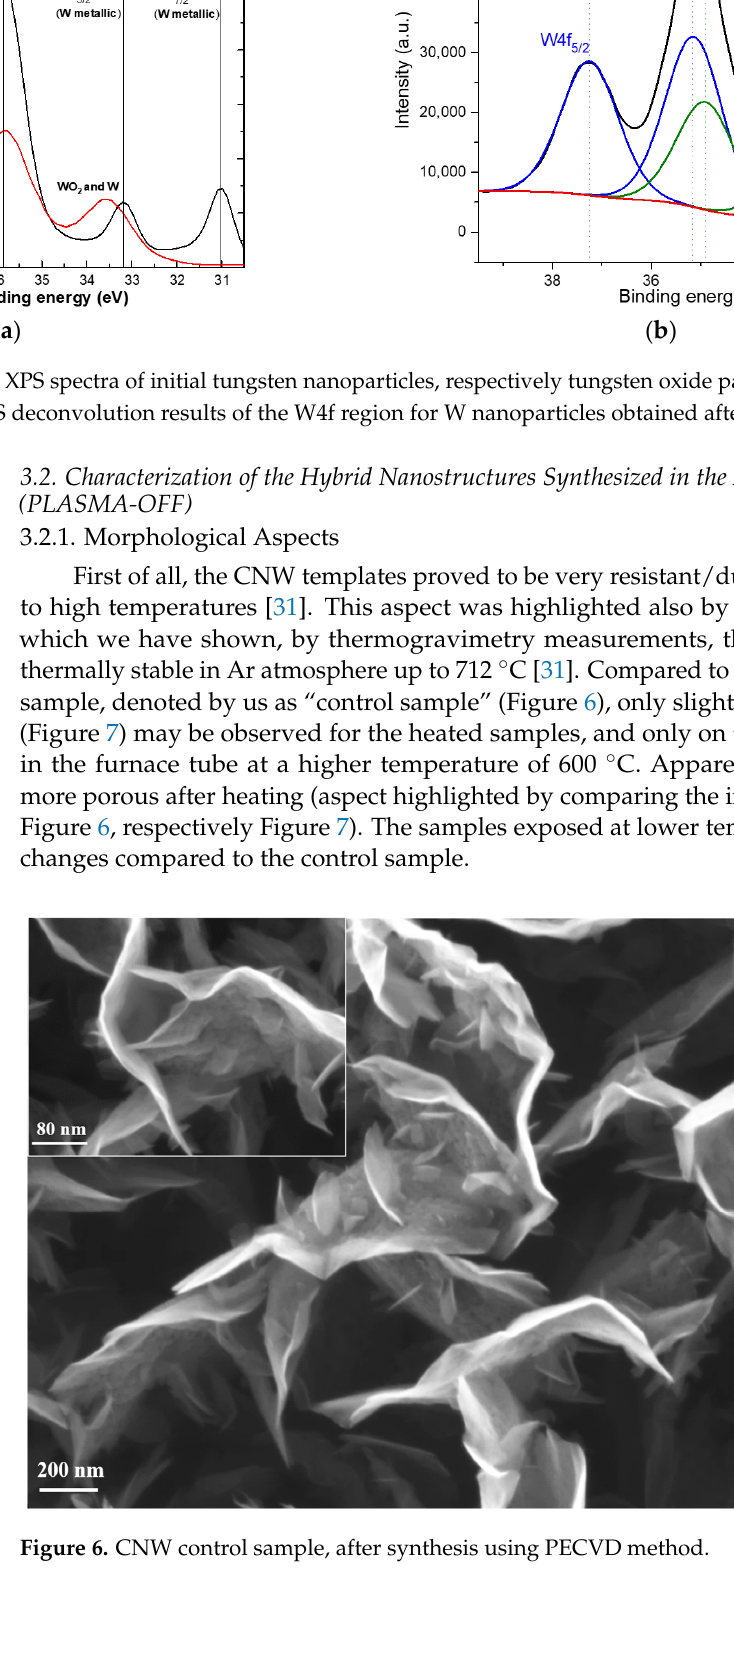
Figure 7. CNW after thermal treatment (No powder source) (600 degrees, plasma off). Concerning the decoration process, it was proved to be very dependent on the sub- strate position in the furnace. This aspect is illustrated by the series of SEM images pre- sented in Figure 8. At 600 °C (Figure 8a), a discontinuous layer of small size particles is observed on the sample, which apparently did not respect the CNW template features. Contrary, at 450 °C (Figure 8c), is hard to observe any decoration of the CNWs. The dec- oration process leads to a hybrid architecture around 550 °C (Figure 8b), where a porous structure with clear dispersion of particles on the CNW skeleton can be observed.